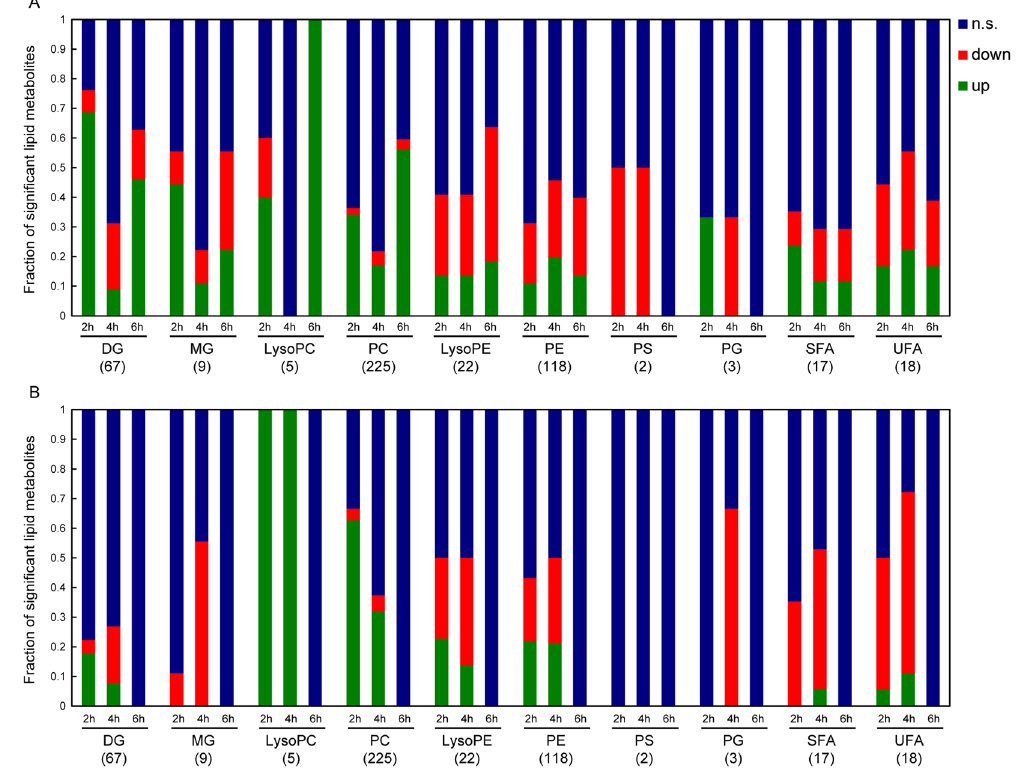
Figure 6. Number of lipid metabolites significantly affected by cold exposure in BAT and SWAT. Fractions of the total number of identified lipids (in parenthesis under the name of the lipid class) in each lipid class that are significantly increased (green), significantly decreased (red) and unchanged (blue; n.s.: non-significant) at 2, 4 and 6 hours cold exposure in BAT ( A ) and SWAT ( B ). DG: diglycerides; MG: monoglycerides; LysoPC: lysophosphatidylcholines; PC: phosphatidylcholines; LysoPE: lysophosphatidylethanolamines; PE: phosphoethanolamines; PS: phosphatidylserines; PG: prostaglandins; SFA: saturated fatty acids; UFA: unsaturated fatty